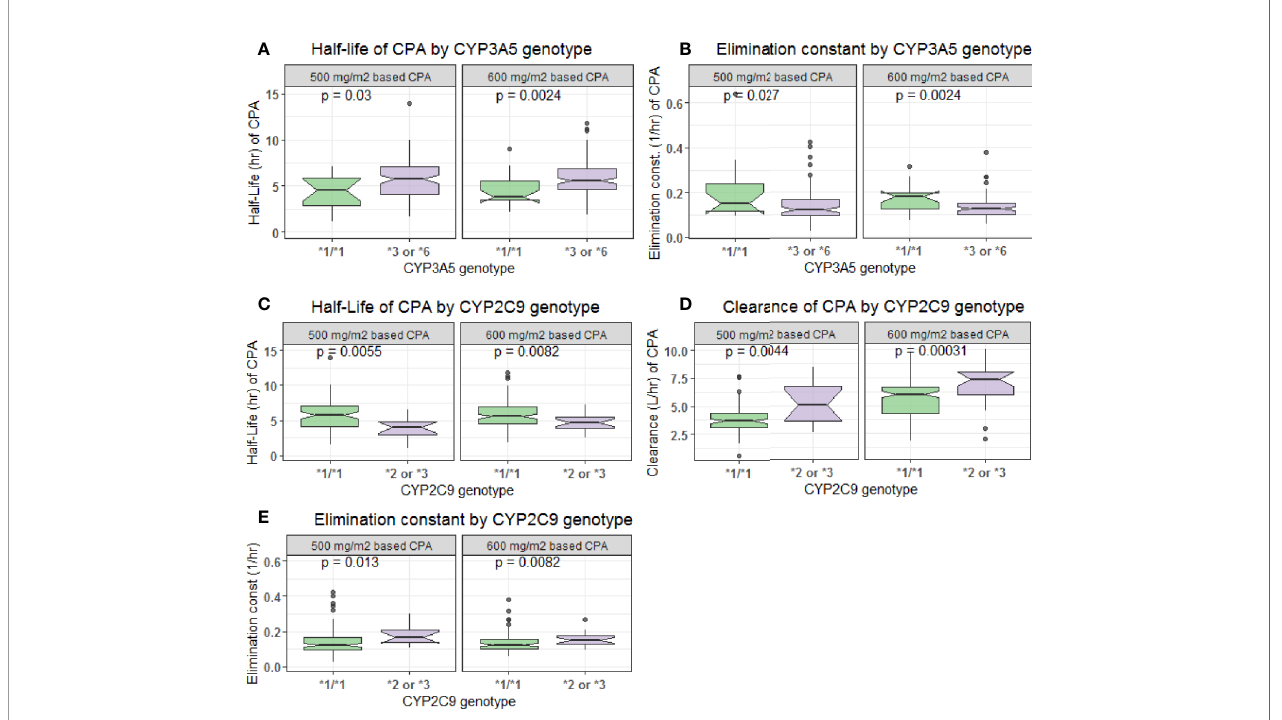
FIGURE 4 | Comparison of clearance, elimination constant and half-life of cyclophosphamide by CYP3A5 (A , B) and CYP2C9 (C – E)